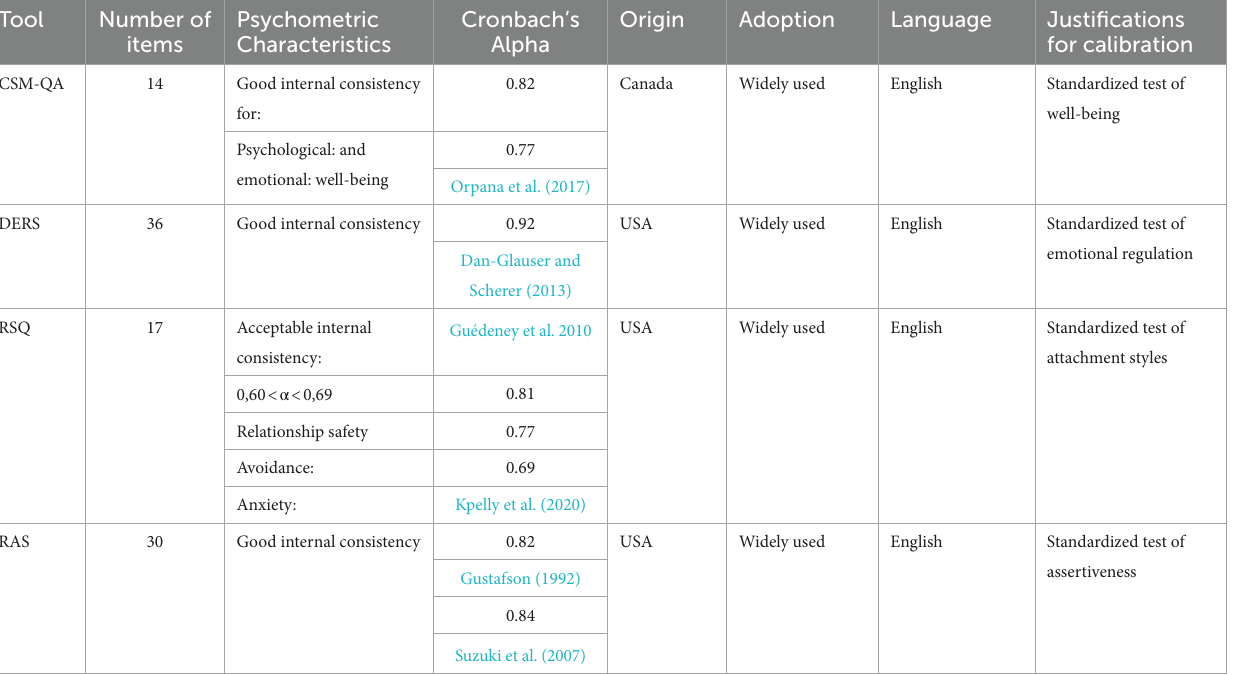
TABLE 2 Characteristics of the measurement